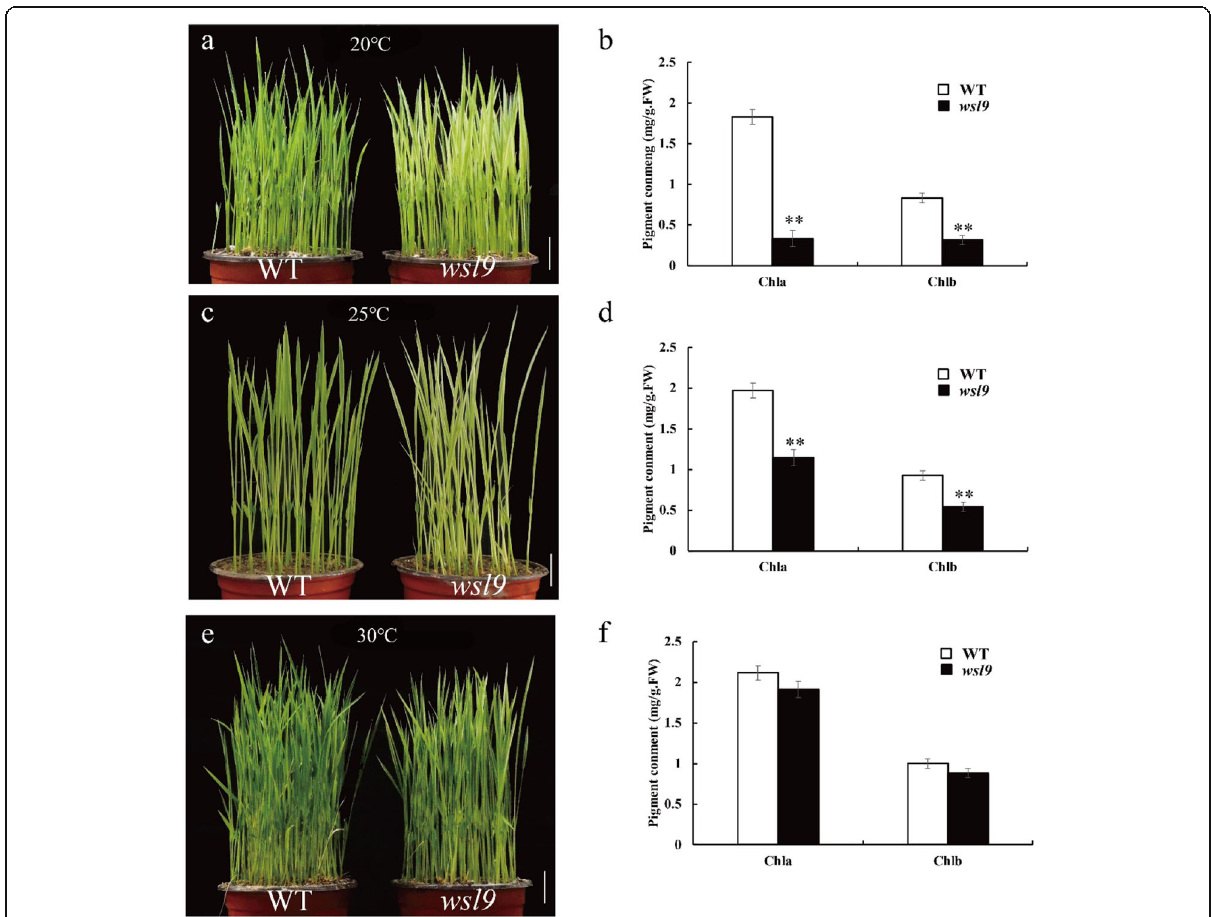
Fig. 3 Responses of the wsl9 mutant to temperature. a , c , e WT and wsl9 mutant seedlings grown at 20 °C, 25 °C, and 30 °C. Scale bar, 2 cm. b , d , f . Chl a and Chl b contents in L3 – 3 leaves from WT and wsl9 mutant seedlings ( n = 3) grown in a growth chamber with the same conditions as ( a , c , e ) (Student ’ s t -tests, ∗∗ , P <